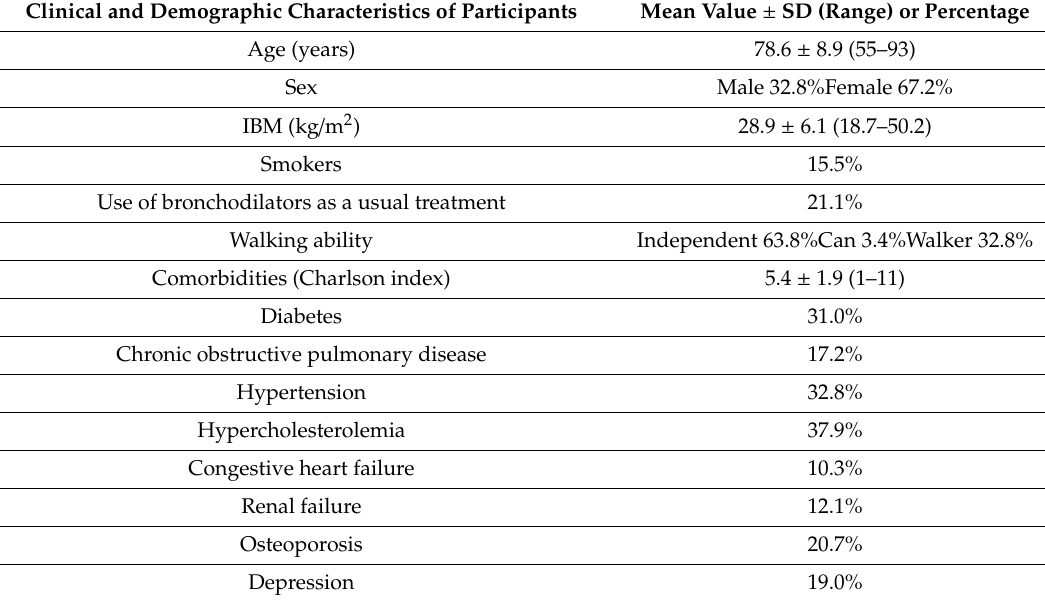
Table 1. Characteristics of the study sample.